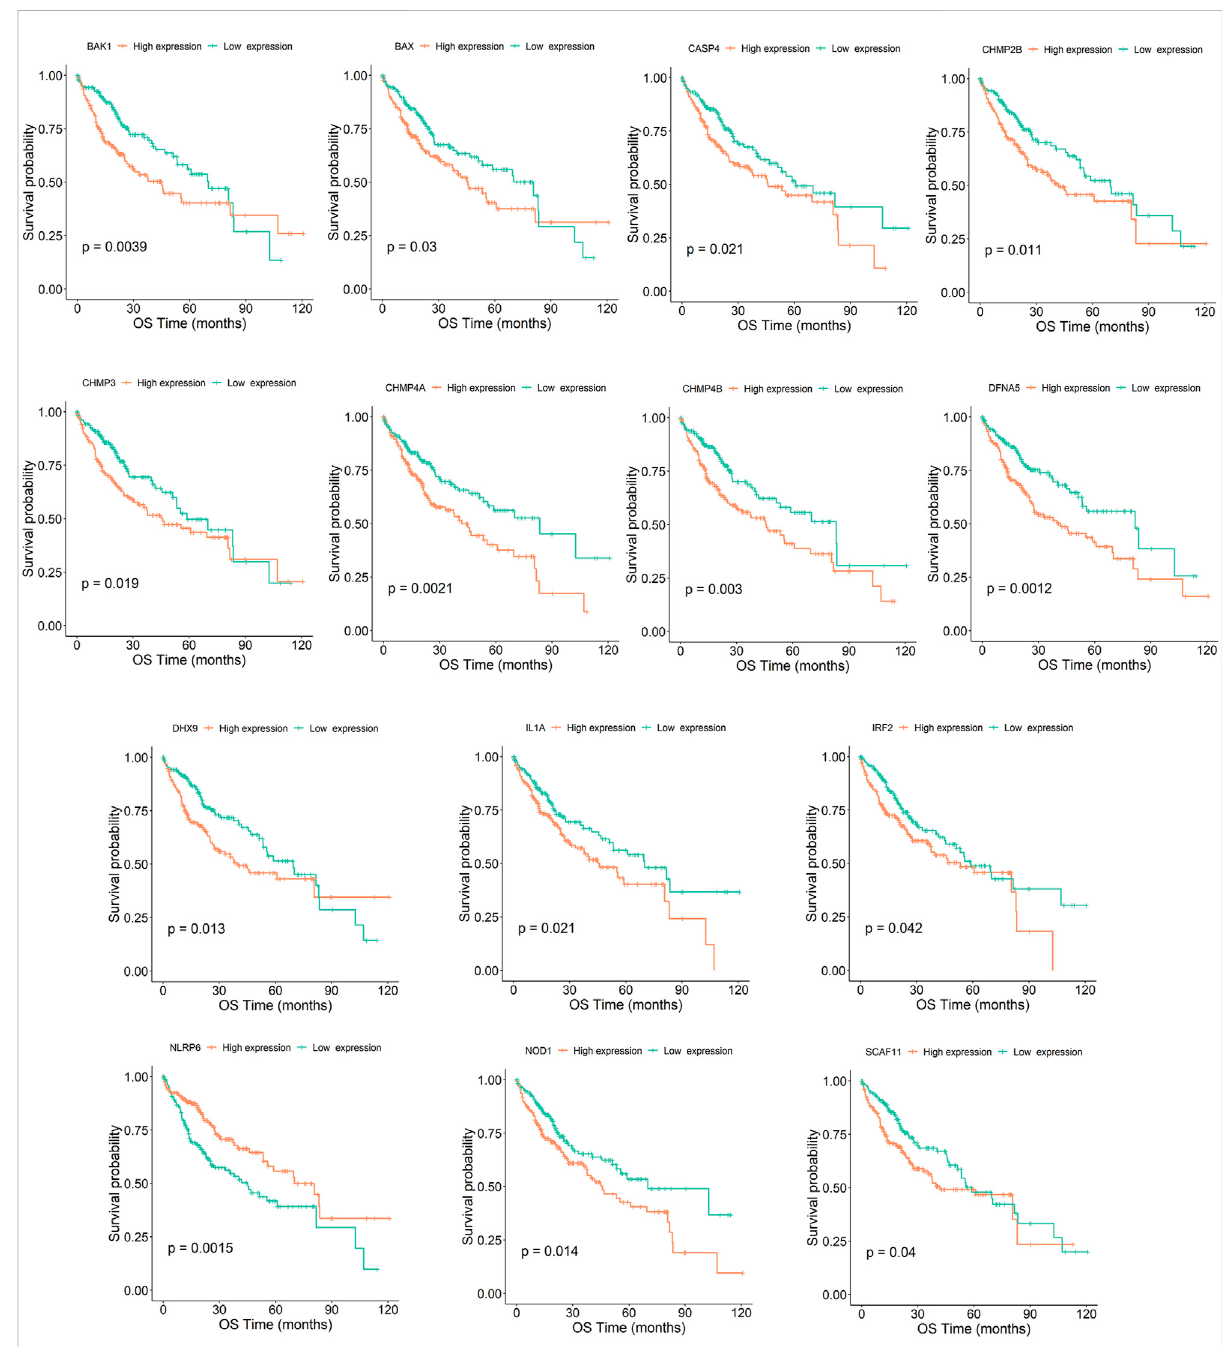
FIGURE 3 Kaplan – Meier survival curve of HCC samples with high- and low-expression of the 14 pyroptosis genes (BAK1, BAX, CASP4, CHMP2B, CHMP3, CHMP4A, CHMP4B, DFNA5, DHX9, IL-1A, IRF2, NLRP6, NOD1, and SCAF11). OS denotes overall